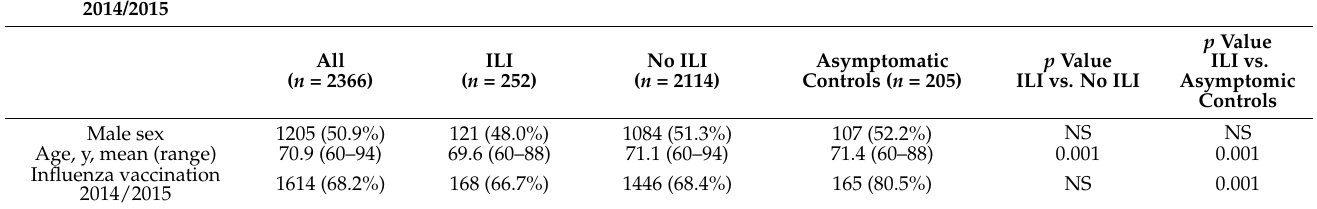
Table 1. Demographic characteristics of participants.